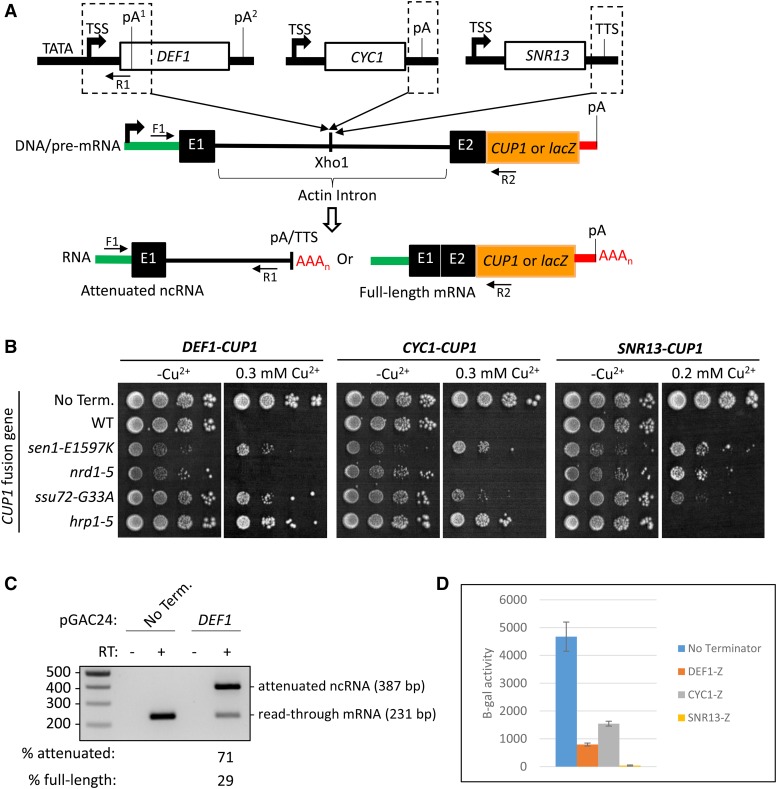
DEF1 promoter-proximal pA site (pA1) is sufficient to confer Pol II transcription attenuation in a CUP1/lacZ reporter assay. (A) Schematic of CUP1/lacZ reporter gene used to measure transcription termination (not to scale). The pGAC24 plasmid contains the actin exon(E1)-intron-exon(E2) fused to a CUP1 or lacZ reporter gene. The promoter-proximal DEF1 pA site, CYC1 pA site, or SNR13 transcription termination site were inserted within the intron. The DEF1 attenuator includes the 5′-UTR and upstream ORF but not the consensus TATA box promoter element. In the absence of a pA/terminator insert (No Term.), full-length mRNA production confers copper-resistance and high β-galactosidase activity. In the presence of a pA/terminator insert, attenuated non-coding RNA (ncRNA) production confers copper-sensitivity and low β-galactosidase activity. Trans-acting mutants that prevent pA/terminator recognition promote copper-resistance and higher β-galactosidase activity. (B) DEF1 pA1 site confers copper-sensitivity in a DEF1-CUP1 reporter, and sen1, ssu72, and hrp1 mutants confer copper-resistance. (C) DEF1 pA1 site reduces expression of CUP1 mRNA due to accumulation of attenuated ncRNA. Note that based on the RT-PCR primer locations (F1, R1, and R2 in panel A), the RT-PCR product from spliced mRNA (231 bp) is shorter than the PCR product from attenuated, unspliced transcript (387 bp). The % attenuated vs. full-length was determined by adding up signal intensities for both bands and determining the relative ratio. No Term. = No Terminator. (D) DEF1 pA1 site reduces expression of a lacZ reporter similarly to known transcription terminators from CYC1 and SNR13. β-galactosidase activity was measured following cell lysis and incubation with ONPG substrate, using absorption at OD600 for cell density and OD420 for product production. Experiments were performed in biological triplicate, and errors bars show standard deviation.